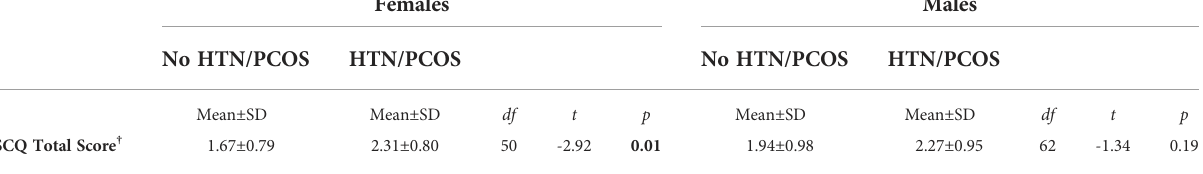
TABLE 2 Group differences on Social Communication Questionnaire strati fi ed by